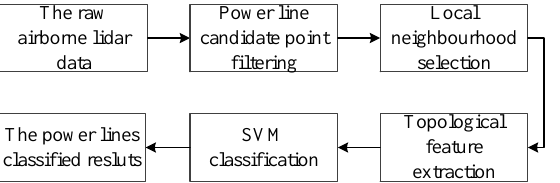
Figure 1. The whole process framework of our methodology.